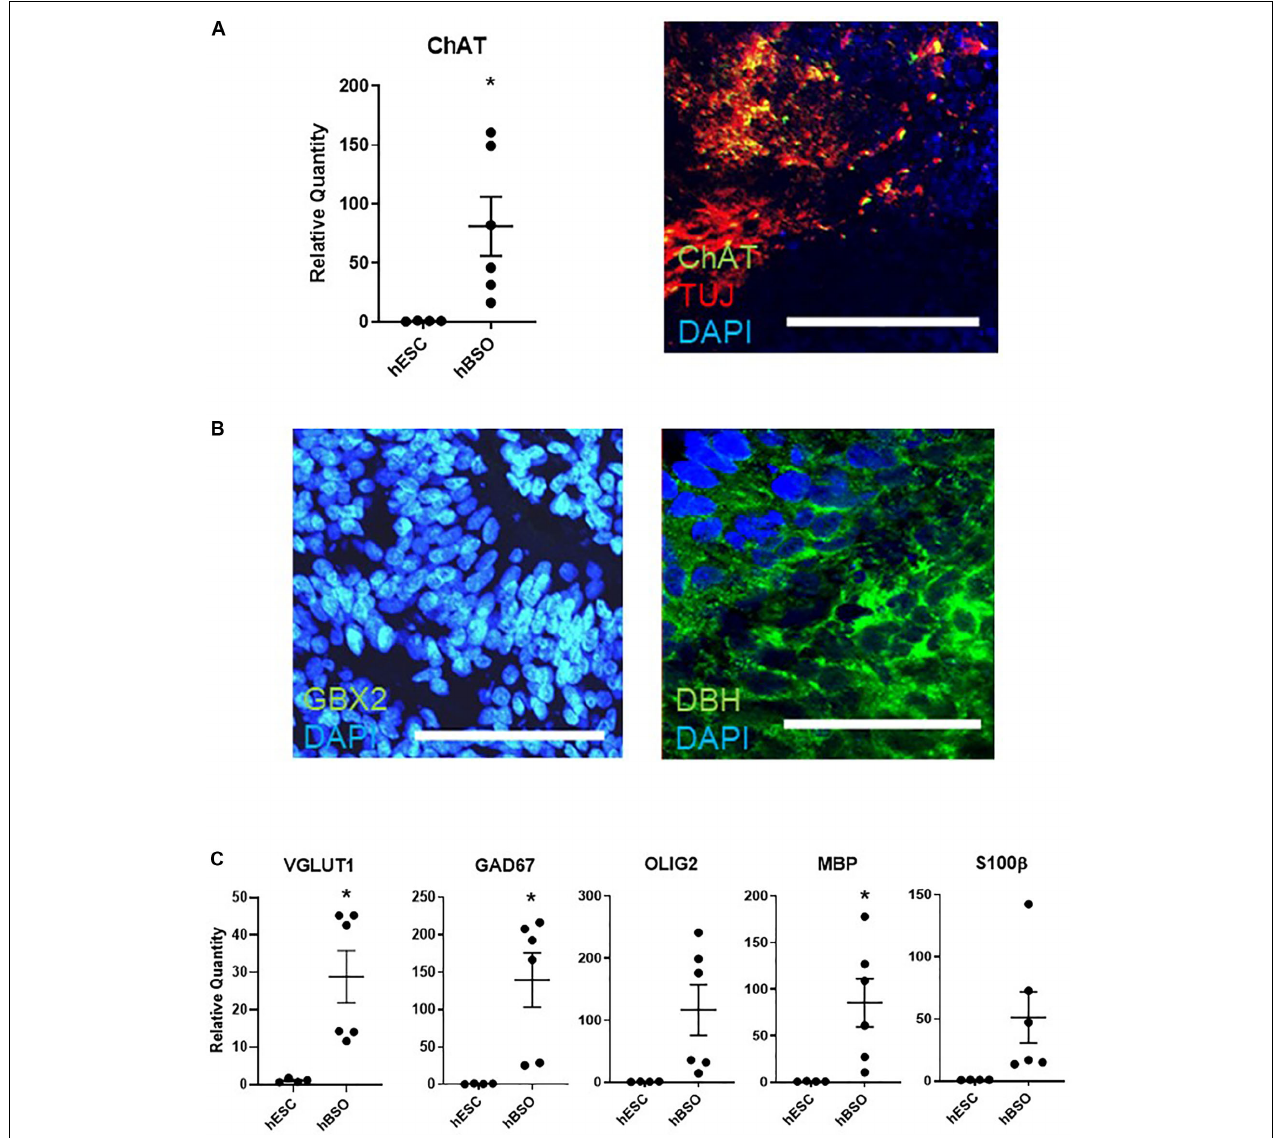
FIGURE 3 | Quantitative PCR and immunohistochemical analysis of 1-month old hBSOs from hESCs. (A) Quantitative PCR analysis and immunohistochemical staining of the marker of cholinergic neuron (ChAT). Error bars indicate mean ± SEM; * p = 0.0337 (ChAT). Bars = 100 µ m. (B) Immunohistochemical staining of DBH, the marker of noradrenergic neuron, and hindbrain marker (GBX2). Bars = 100 µ m. (C) Quantitative PCR analysis for the marker of excitatory neuron (VGLUT1), inhibitory neuron (GAD67), oligodendrocyte (OLIG2, MBP), and astrocyte (S100 β ). Error bars indicate mean ± SEM; * p = 0.0127 (VGLUT1), * p = 0.0155 (GAD67), * p = 0.0320